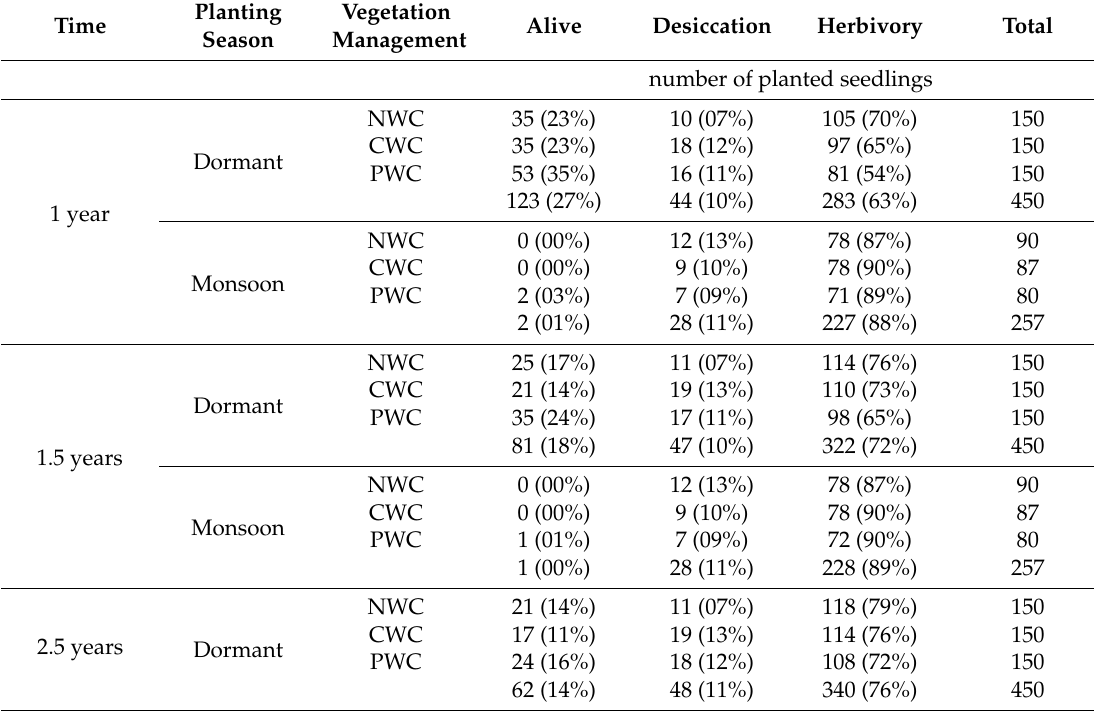
Figure 3. Longitudinal survival rates of planted ponderosa pine seedlings in the Davis Mountains as a function of time since planting ( A ) and study timeline ( B ). Table 4. Apparent cause of death contingency table for planted ponderosa pine seedlings in the Davis Mountains in all planting season and vegetation management a treatments.